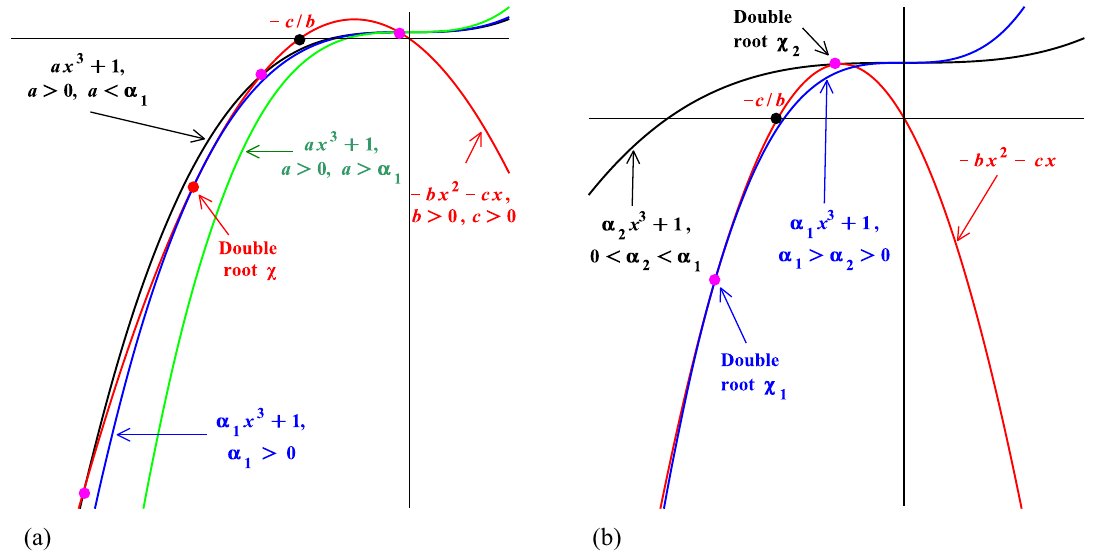
Figure 3: The cubic equation ax bx cx 1 − − 3 2 + = with a 0 > , b 0 > , and c 0 > .